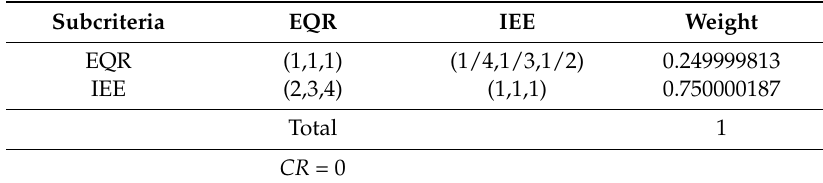
Table A21. Comparison matrix for